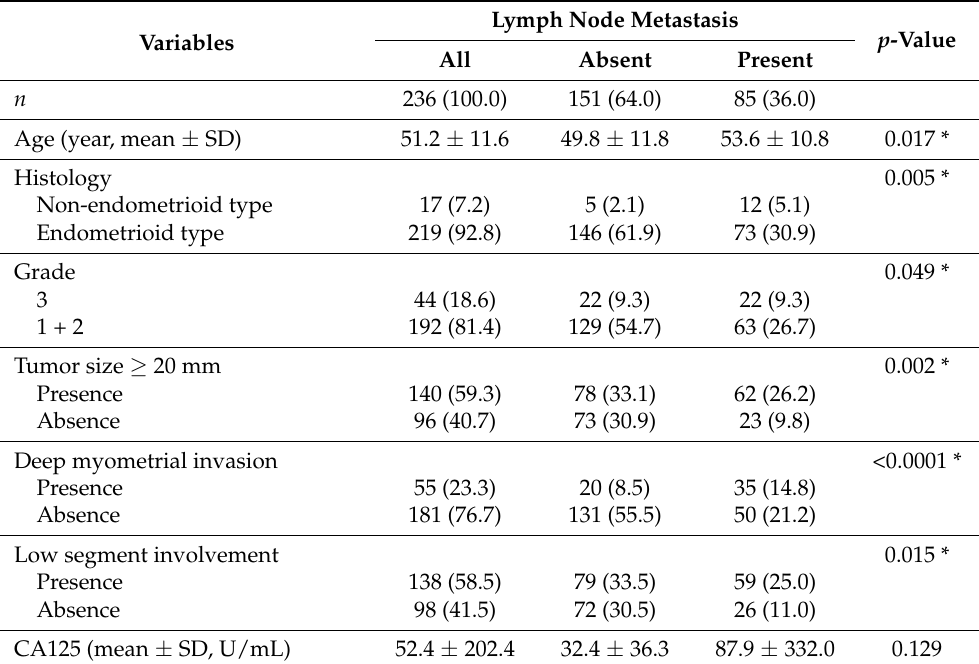
Table 2. Characteristics of patients according to the risk group based on radiomics parameters